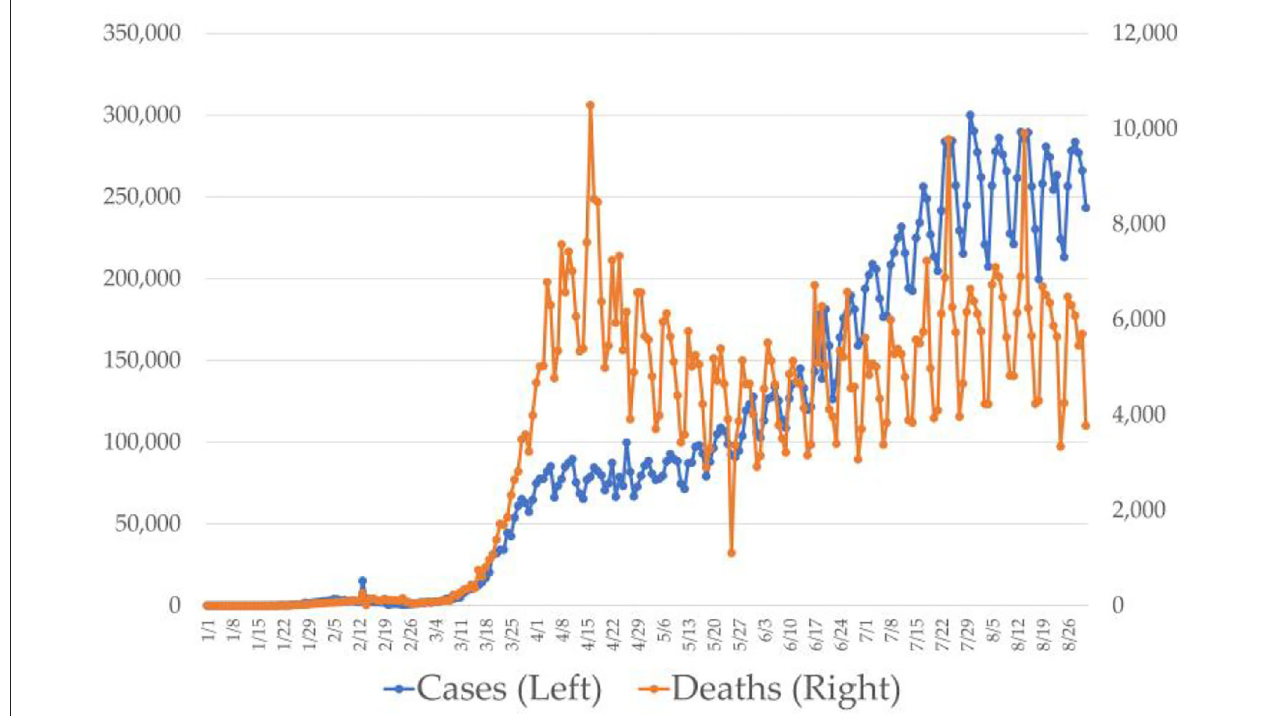
FIGURE 1 | Coronavirus diseases 2019 (COVID-19) cases and deaths recorded during the first wave ( X -axis, number of deaths; Y -axis, cases reported on a daily basis).